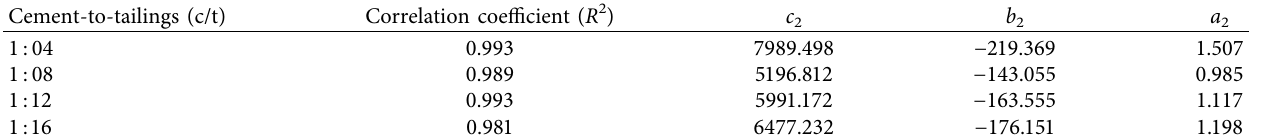
Table 11: Viscosity fitting results of CUTB samples under various